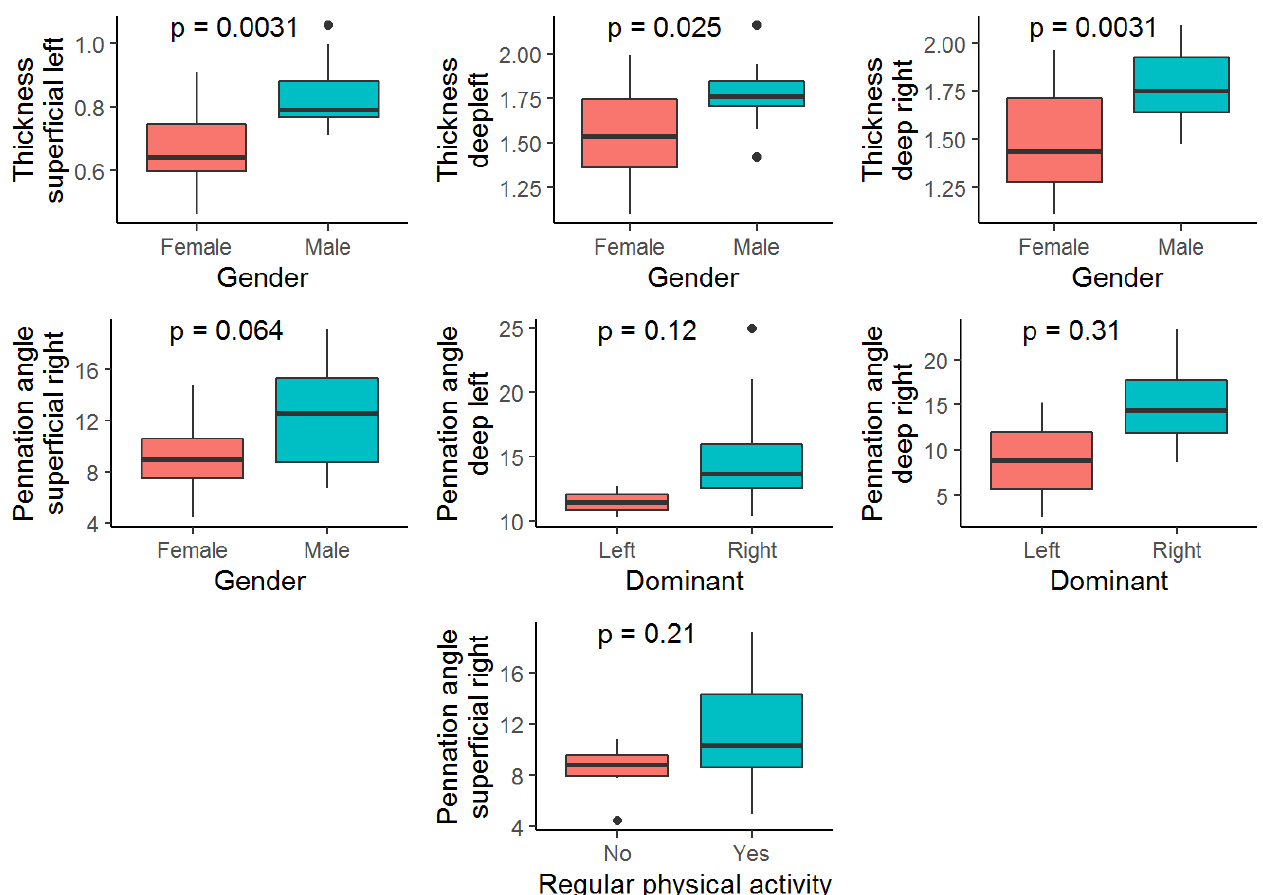
Figure 3. Higher correlations boxplots by gender, dominant side, and physical activity. The Pearson correlation coefficient except for pairwise that includes Pennation angle deep left variables, which shower the Spearman correlation coefficient. The scatter plots for thickness and the pennation angle are shown below (Figure